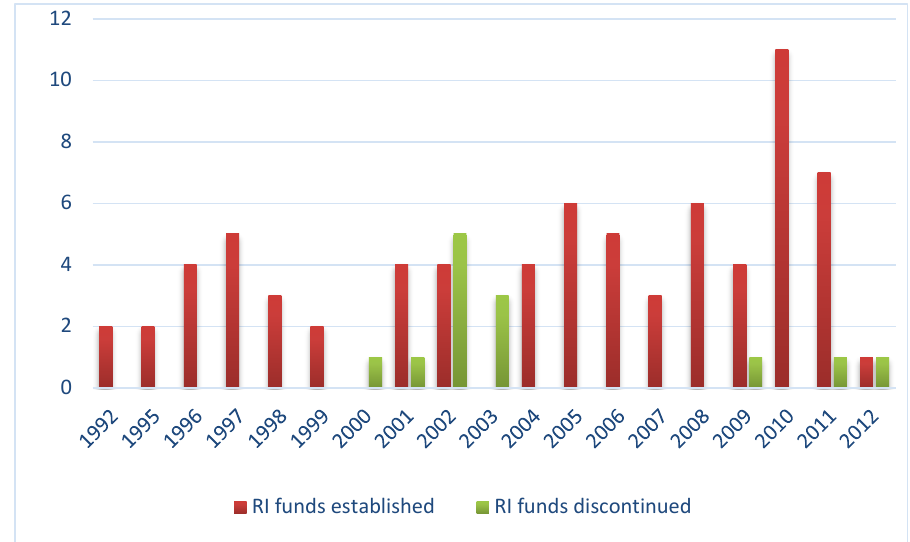
FIGURE 1: RI funds established and discontinued in South Africa over the period 1 June 1992 - 31 December